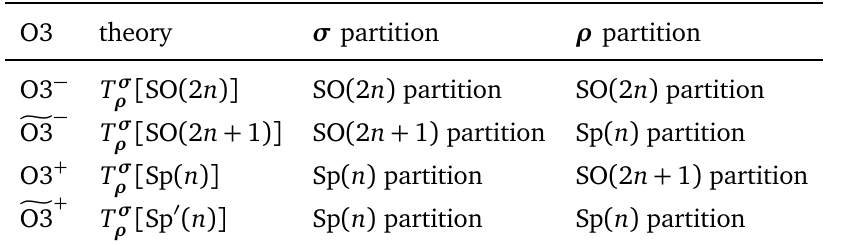
[ G ] theories are defined by a G -partition σ and a G ∨ -partition ρ , Table 9: The T σ ρ with G ∨ the GNO-dual group of G